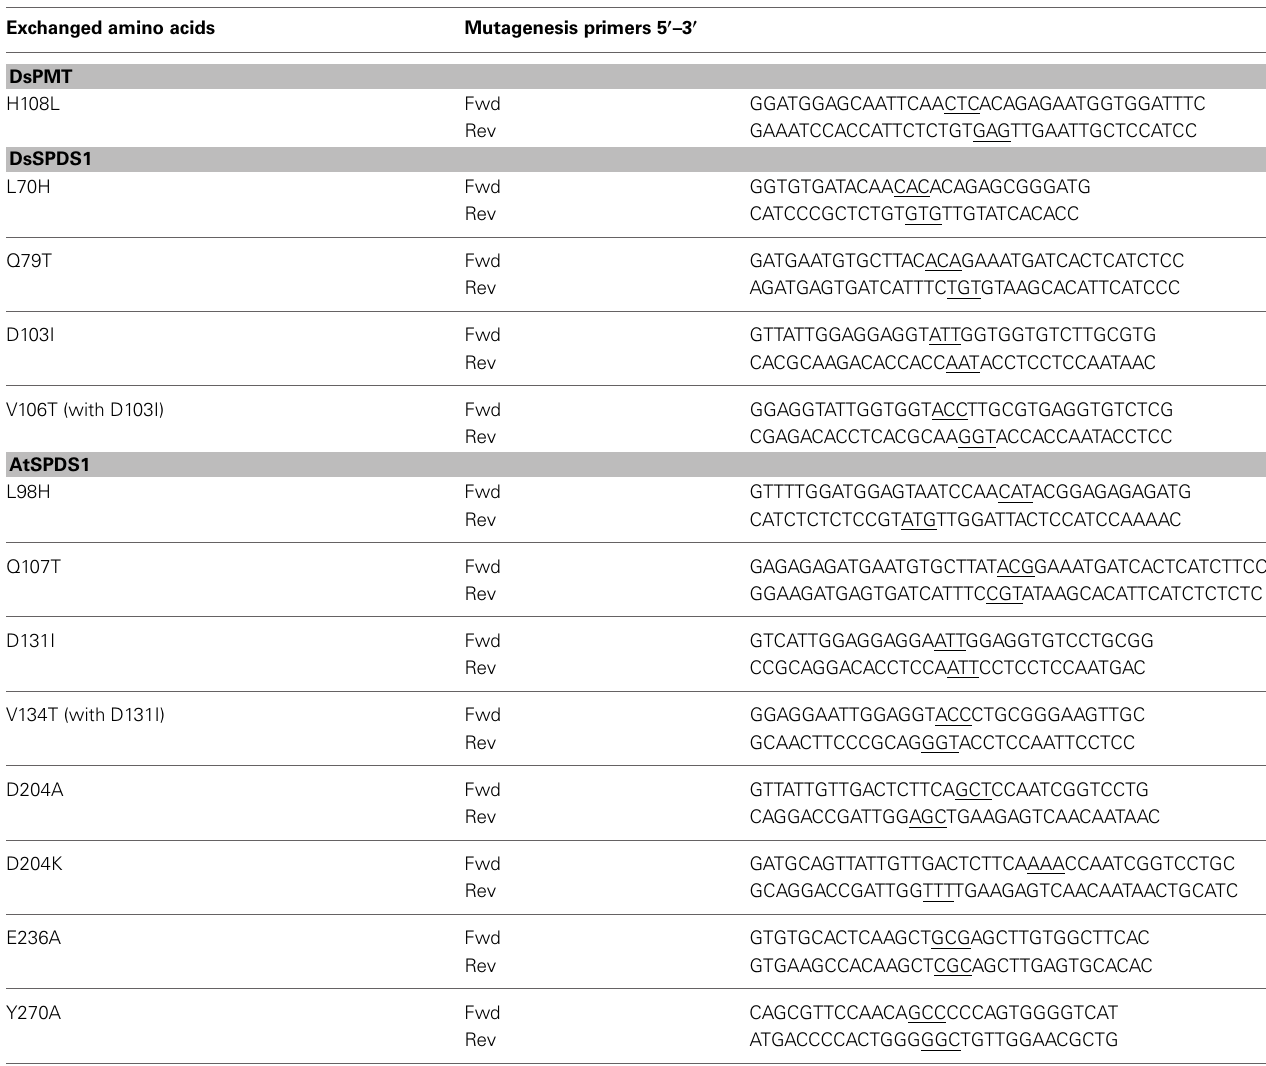
Table 1 | Primers for mutagenesis of DsPMT, DsSPDS1 and AtSPDS1, mutated triplets are underlined. Exchanged amino